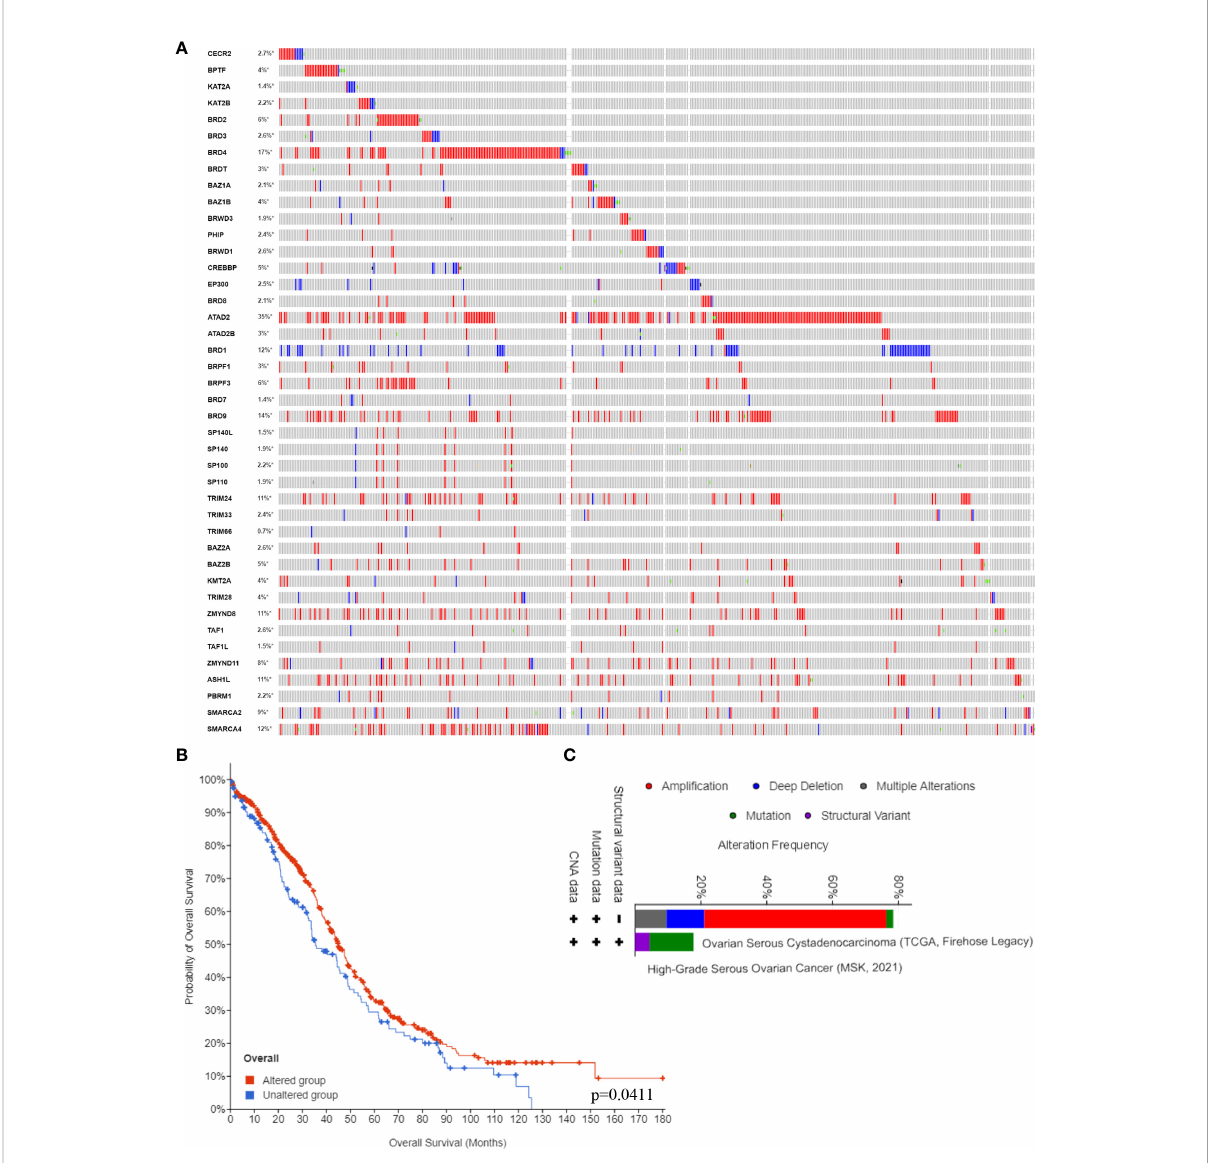
FIGURE 3 BRD DNA alteration levels in the OSC. (A) The DNA alteration levels of BRDs in OSC samples and normal ovary samples based on the cBioPortal database. (B) The overall survival analysis of OSC patients with or without BRD DNA alterations. (C) The types of BRG alterations in OSC samples based on the cBioPortal database. *p <